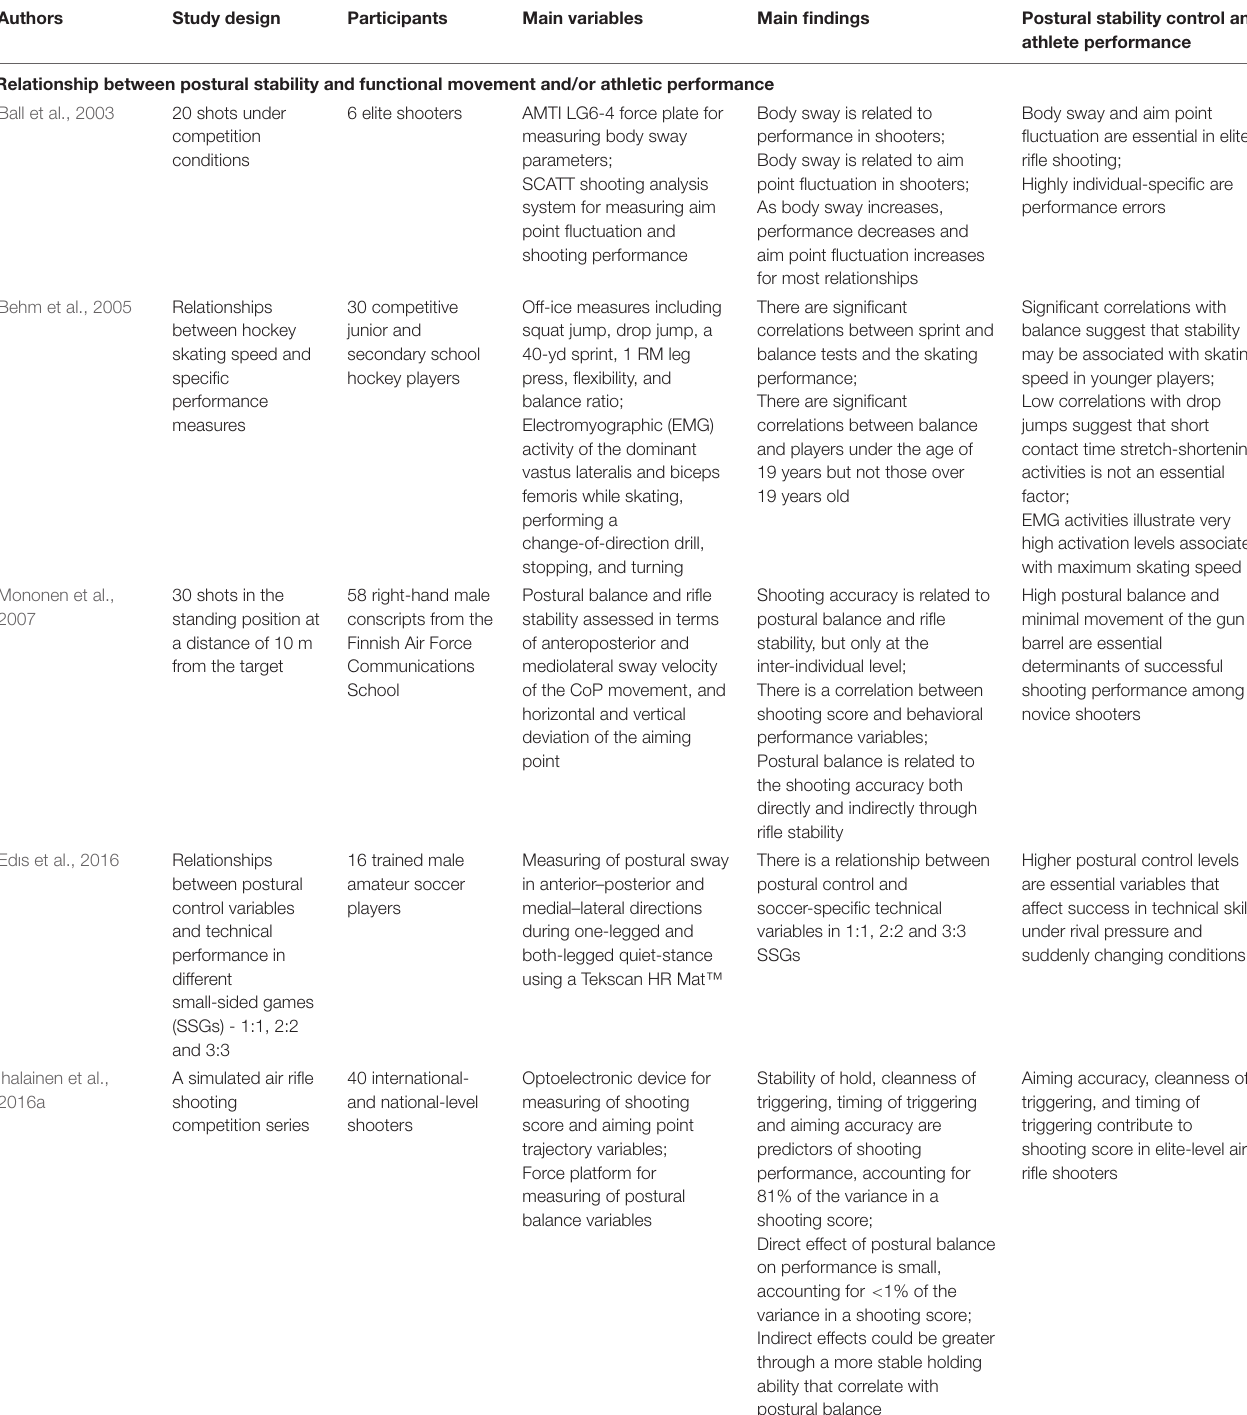
TABLE 1 | Neuromuscular control of postural stability and functional movement and/or athlete